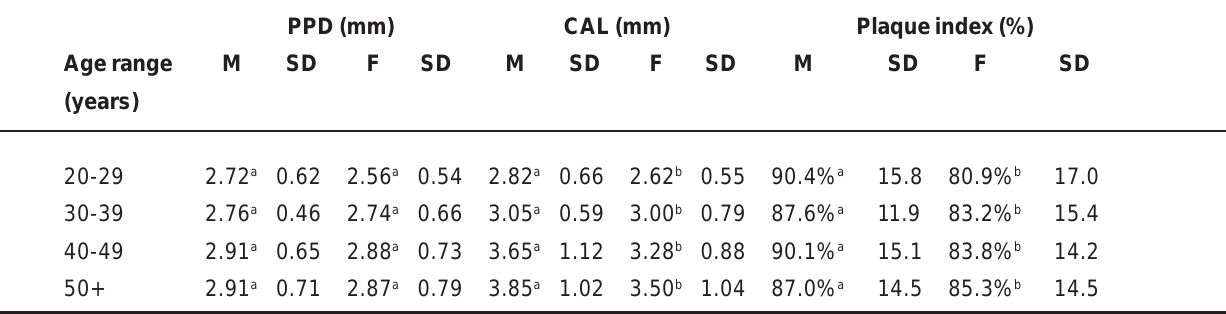
SD = standard deviation ANOVA and Tukey´s test (p<0,05)